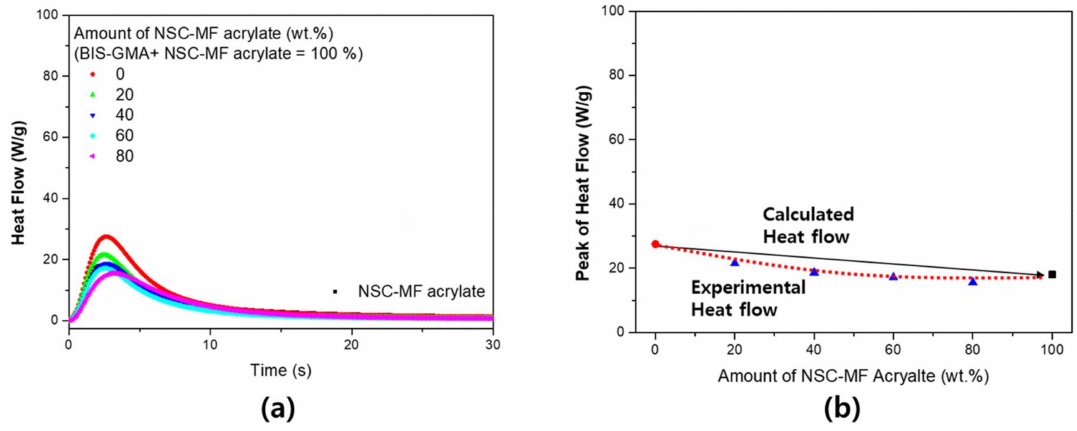
Figure 16. Heat flow of the NSC-MF acrylate and BIS-GMA blended system: ( a ) real-time heat flow; and ( b ) maximum heat flow of the blended